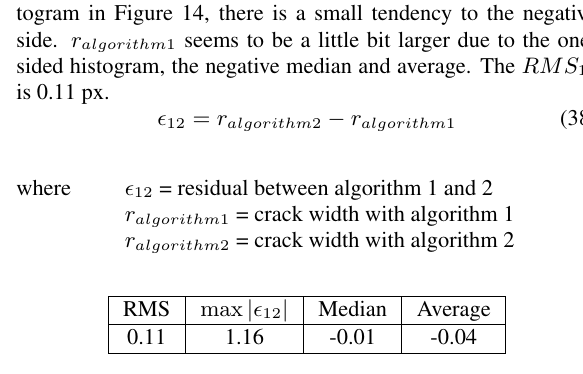
Table 2. Statistical values of the residuals between algorithm 1 and algorithm 2 in px